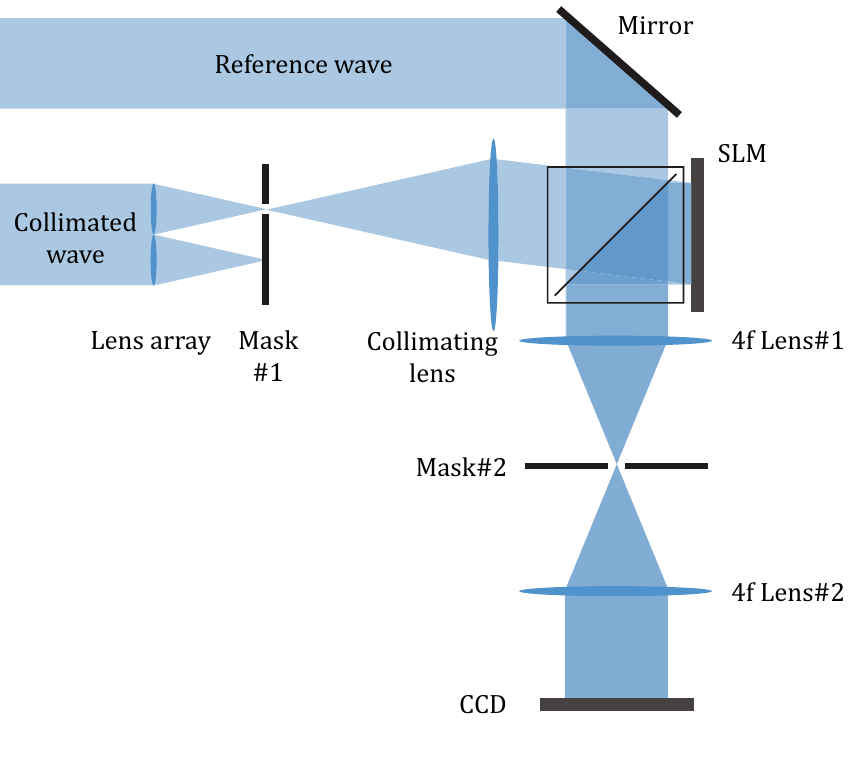
Figure 8. Schematic diagram of a Mach-Zehnder interferometer setup for wavefront measurement of a mutually coherent multi-directional wave. The spatial mask #1 is opened corresponding to the lenslet whose optical aberration is to be measured, and the mask #2 selects the position on the spatial frequency domain where optical aberration is to be